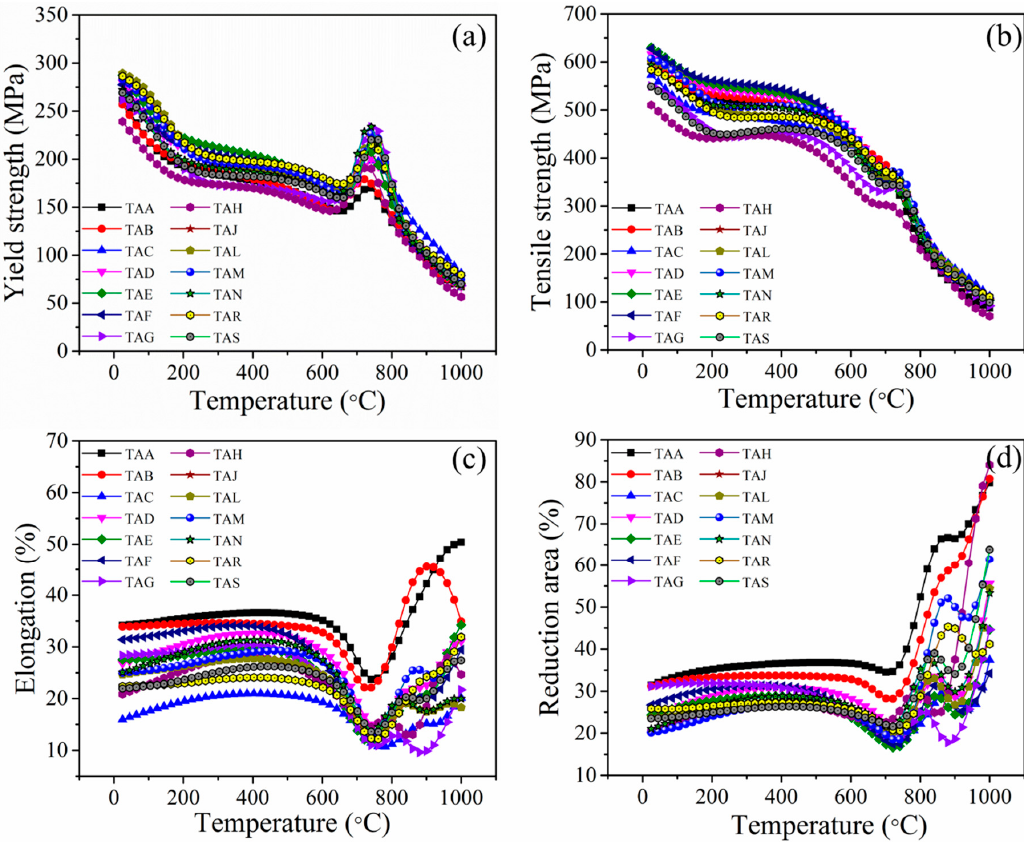
Figure 5. Effect of service temperature on tensile properties of 25Cr-20Ni-04.C steels: ( a ) YS, ( b ) UTS, ( c ) % El and ( d ) % RA. Metals 2020 , 10 , x FOR PEER REVIEW